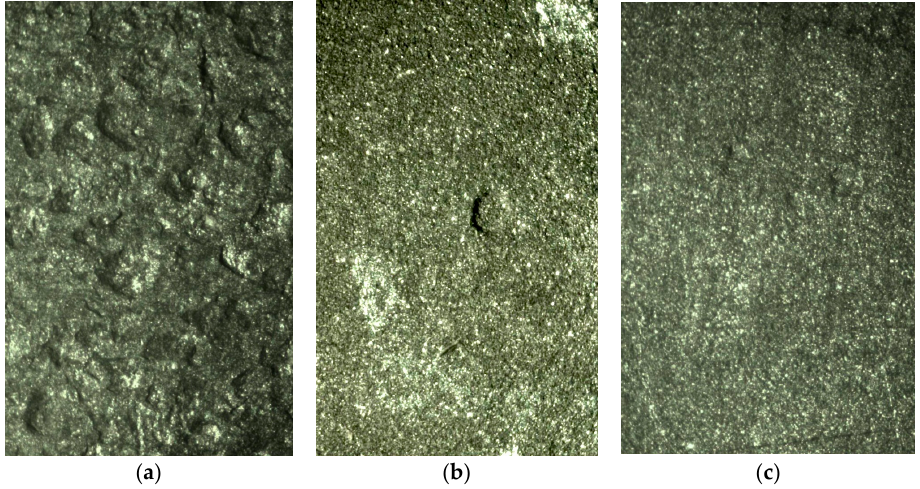
Figure 2. Typical surfaces of cleaned coupons all after 56 days exposure in natural seawater at 17 °C (ave.): ( a ) steel A, showing some larger pits and a multitude of smaller pits; ( b ) steel B with one larger pit at about centre and many smaller pits; and ( c ) steel C with fewer pits that are also of smaller size. In each case the corrosion pits are easily differentiated from surface topography and any surface imperfections. The pitting severity (density, depth) reduces from steel A to steel C (left to right). Generally similar images were obtained at 28 days exposure at 17 °C (avg.) and at 28 and 56 days exposure for seawater heated to 30 °C. Scale: horizontal dimension of each image corresponds to 5 mm. The corroded surfaces were compared to corresponding images of coupons (blanks) that had not been exposed in order to ascertain the extent and severity of initial surface condition. The surfaces of coupons made from steel A showed some surface imperfections but, as noted, these are distinctly different in appearance from corrosion pits. For steels B and C the unexposed surfaces were remarkably free from surface imperfections (Figure 2b,c).